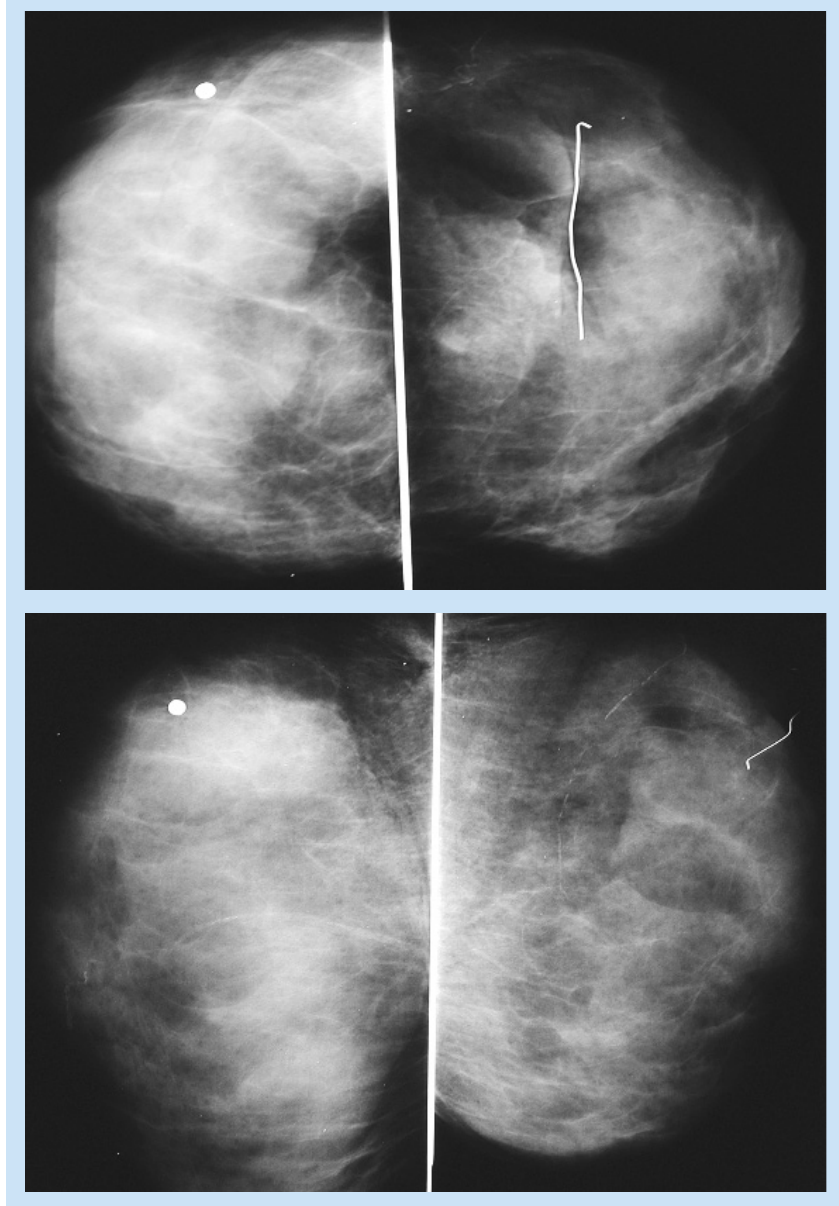
Fig.2a,b.Craniocaudal and mediolateral mammograms of case 2 demonstrate diffusely dense breasts. The left marker outlines the scar from the abscess drainage